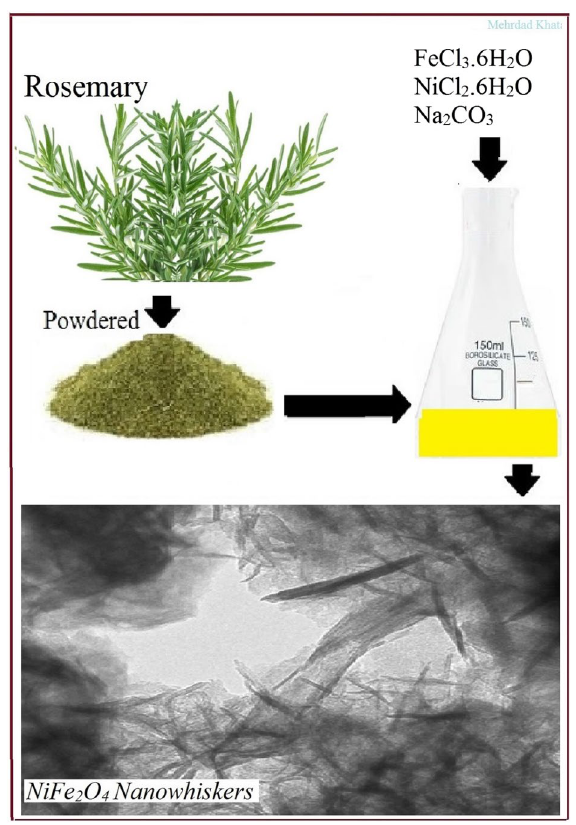
Figure 5. Schematic of nickel-ferrite nanowhiskers synthesis using rosemary